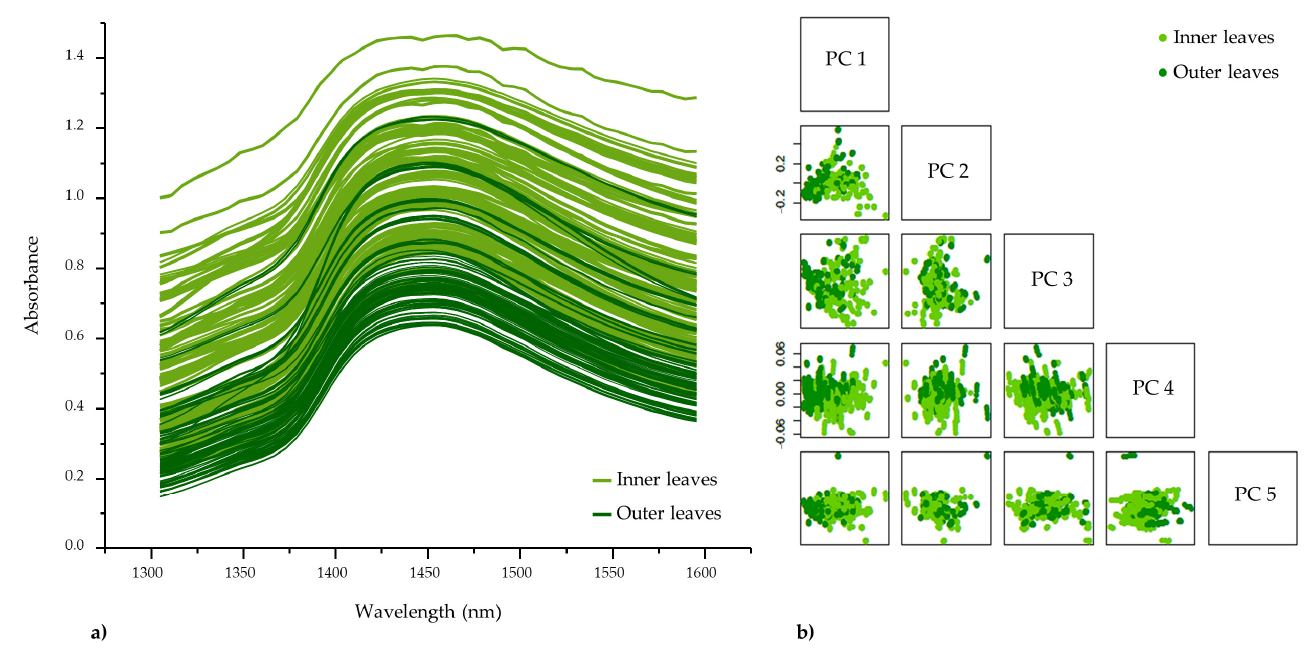
Figure 5. ( a ) Raw spectra of lettuce leaves (N = 900); ( b ) PCA score plot on raw data colored according to “lettuce leaves” (N = 900).